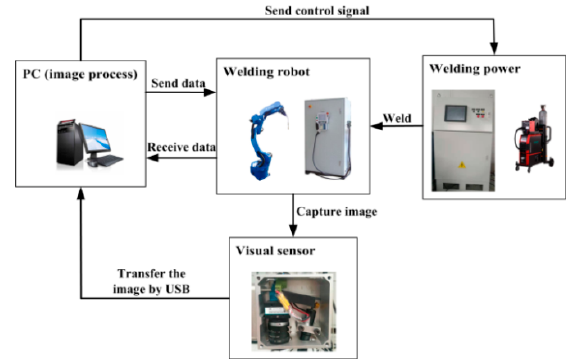
Figure 17. System configuration. Table 2. Weld joint parameters.